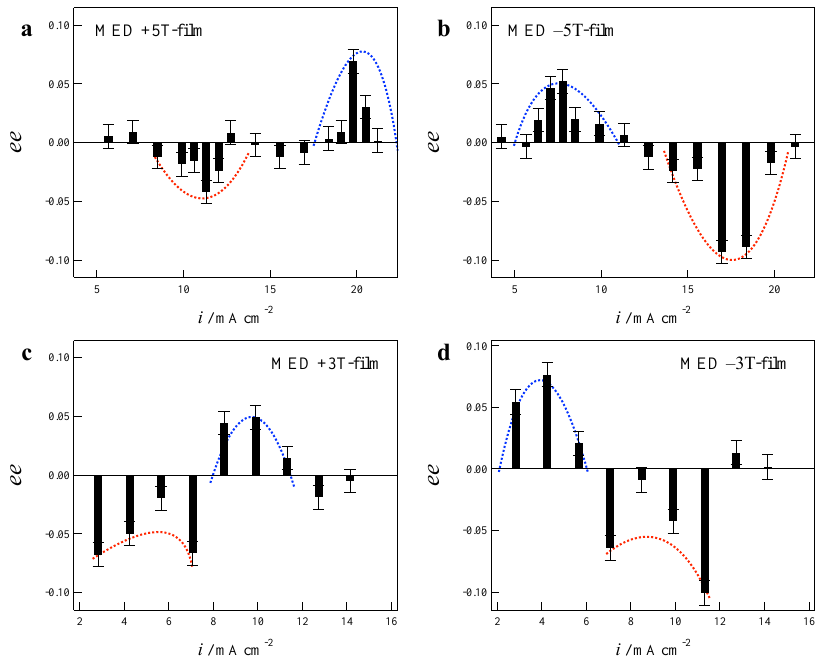
Figure 3. The ee ratios vs. deposition currents. ( a ) MED + 5T-film, ( b ) MED − 5T-film, ( c ) MED + 3T-film and ( d ) MED − 3T-film. Dotted curves are a guide for the eye.